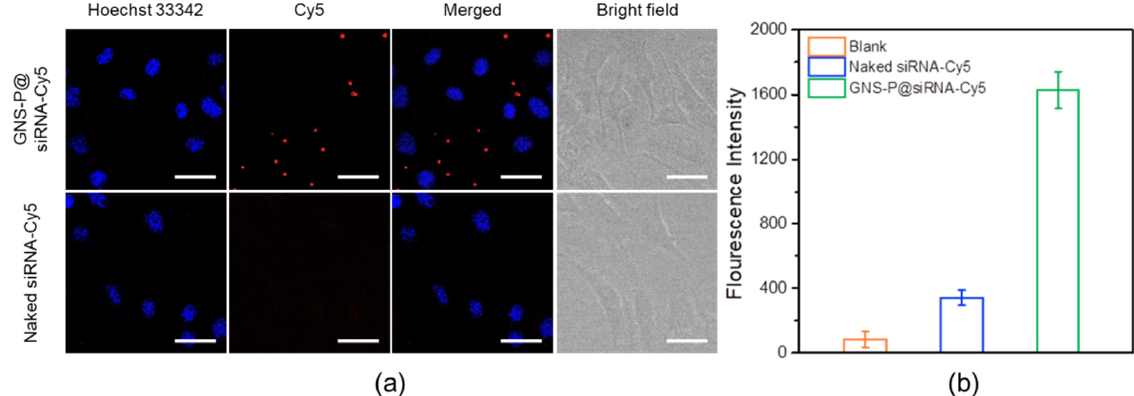
Figure 8. ( a ) Intracellular uptake of GNS-P@siRNA-Cy5 by Panc02 cells (scale bar: 100 µ m); ( b ) Quantitative analysis of GNS-P@siRNA-Cy5 internalization by Panc02 cells.